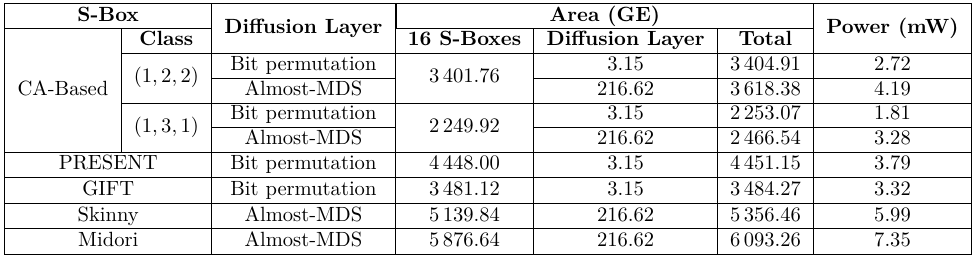
Table 6: Lightweight TI for SPN block cipher: area and power (ASIC Technology: 180nm)